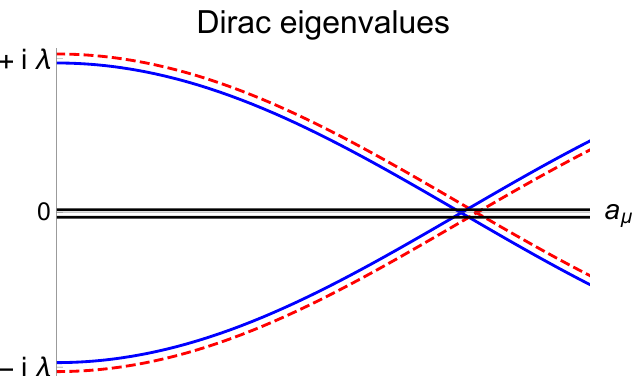
Figure 1: Sketch of the flow of eigenvalues of the massless Dirac operator as a func- tion of the bosonic field a µ on an orientable manifold. The non-zero eigenvalues come in quartets, with two modes with eigenvalue + i λ and another two with eigen- value − i λ . We also sketch a pair of Dirac zero modes with opposite chirality. Since quartets of non-zero modes must go through zero together, the number of e.g. right- handed zero modes mod 2 is a topological invariant, which we call ζ . For clarity of presentation, all degenerate eigenvalues are shown slightly offset from each